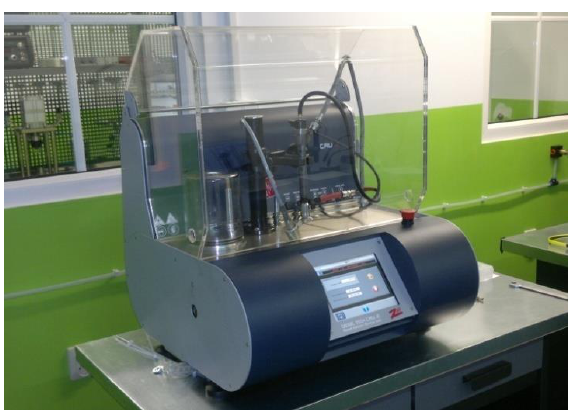
Fig. 3. Diesel Bench CRU 2 Zapp auxiliary diagnostic test bench